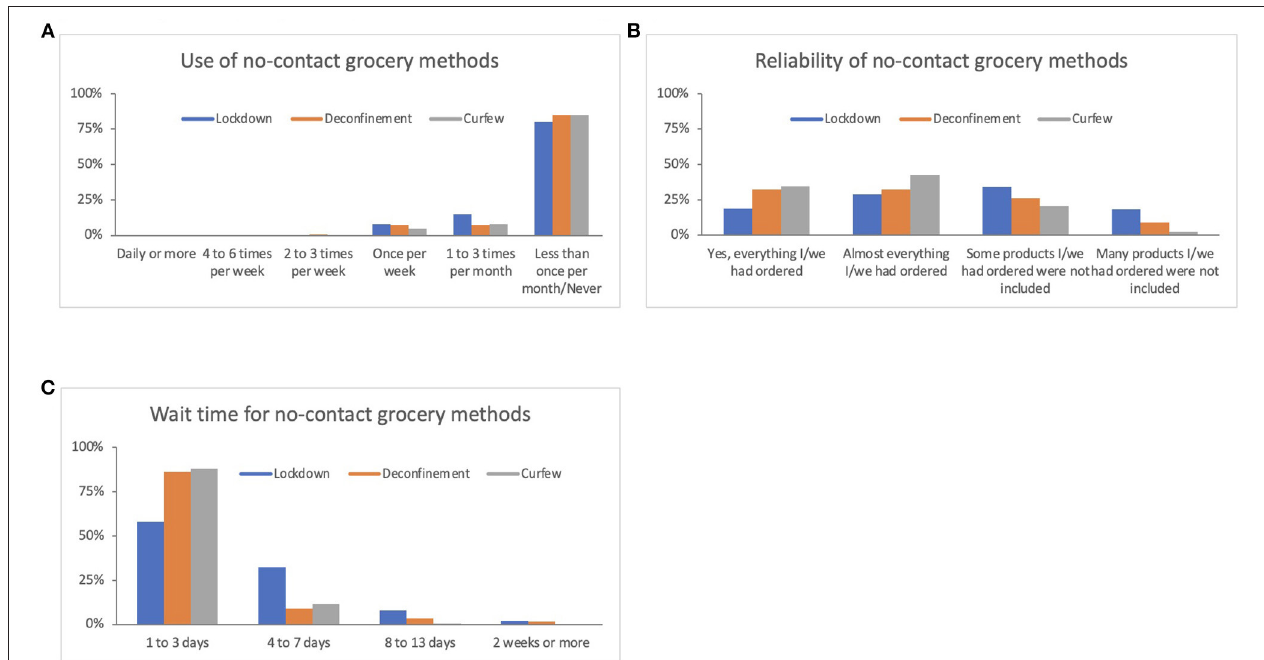
FIGURE 2 | Changes in use, completeness, and wait time for no-contact grocery methods. (A) “Between (time period) how often did your household utilize grocery pick-up or home delivery?” Wilcoxon signed-rank test: Lockdown vs. Deconfinement p < 0.001 , Deconfinement vs. Curfew p = 0.318. (B) “If you used grocery pick-up or delivery, were all the products your household ordered included in what you received?” Wilcoxon signed-rank test: Lockdown vs. Deconfinement p < 0.001 , Deconfinement vs. Curfew p = 0.005. (C) “If you used grocery pick-up or delivery, on average, after placing your order how long did you have to wait to receive your groceries?” Wilcoxon signed rank-test: Lockdown vs. Deconfinement p < 0.001 , Deconfinement vs. Curfew p =